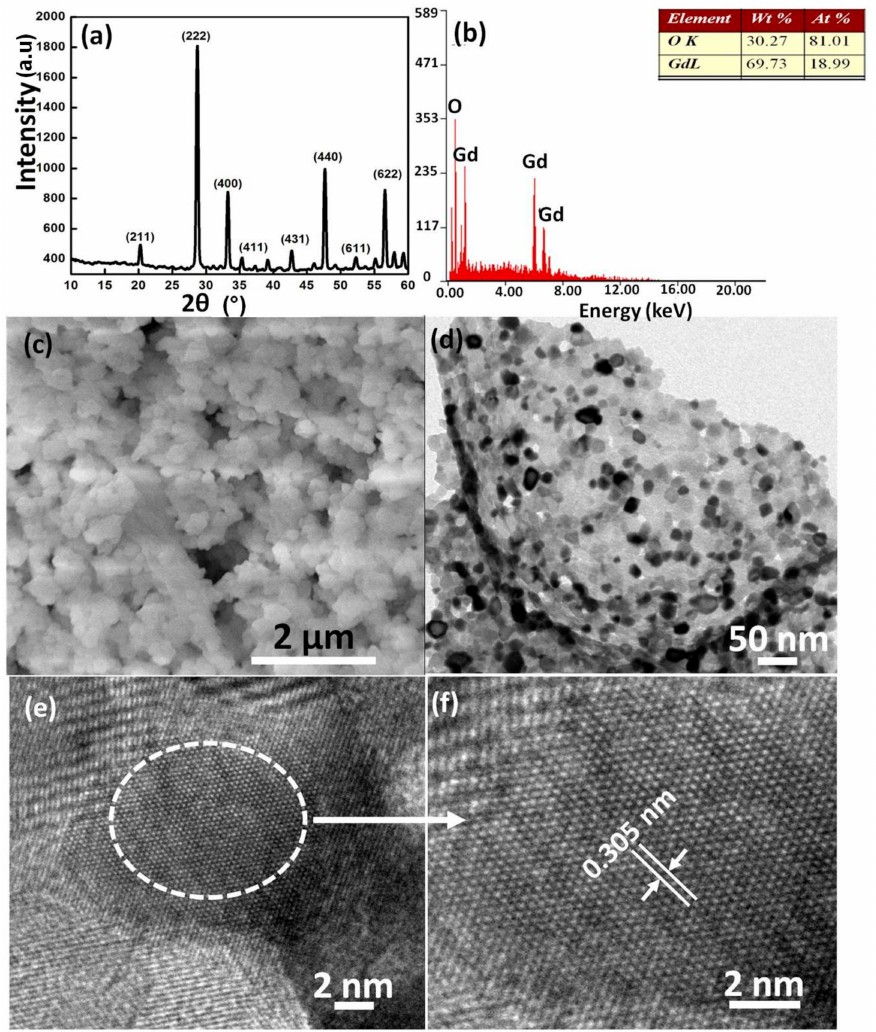
Figure 1. Typical ( a ) XRD pattern, ( b ) EDS spectrum, ( c ) SEM image, ( d ) TEM image, and ( e , f ) HRTEM images of Gd 2 O 3